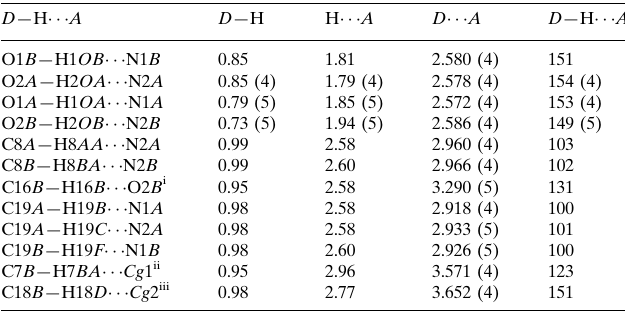
Data collection Bruker APEXII CCD area-detector diffractometer Absorption correction: multi-scan ( SADABS ; Bruker, 2005)